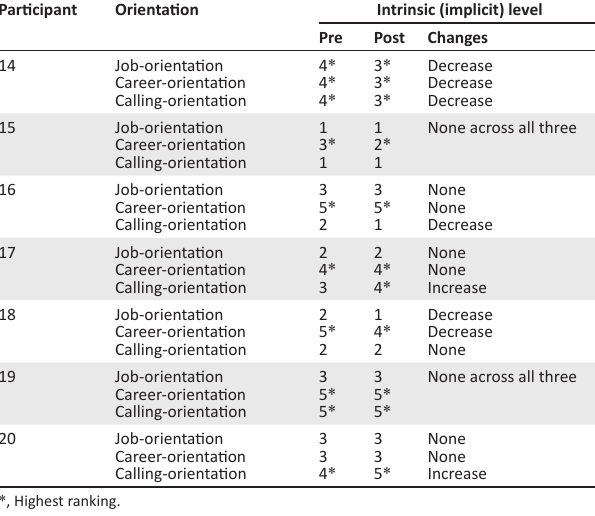
TABLE 2 (Continues...): Change in scores on the intrinsic (implicit)